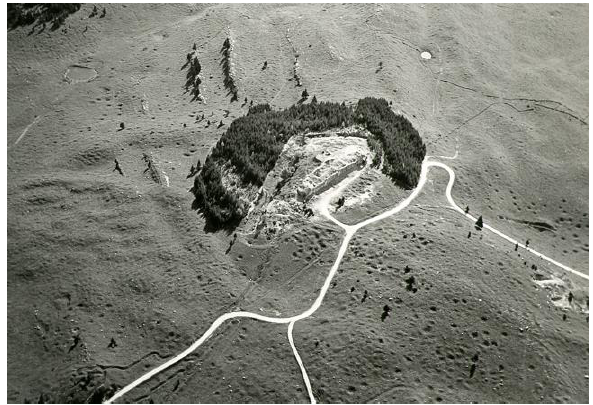
Figure 2 . Busa Verle fort: historical aerial